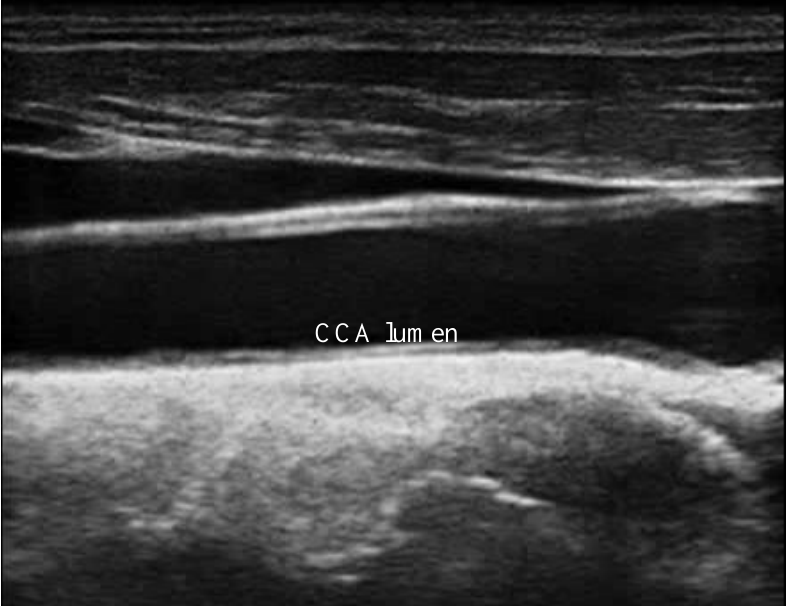
Figure 2. A sub-image from a B-mode sonographic image sequence. This patient has thin IMT. (Sequence S2: Male, 56 yr old).